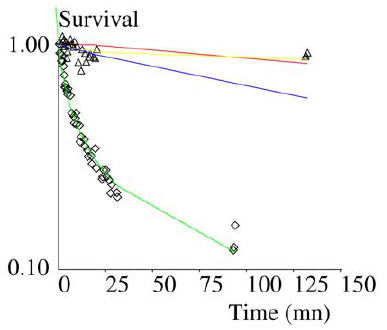
Figure 5. Force free survival of attachments between micro- spheres and ICAM-1-coated surfaces. Anti-ICAM-1-coated Qdots were incubated with surfaces coated with monovalent (diamonds) or divalent (triangles) ICAM-1 and spontaneous detachment was de- termined by counting bound Qdots on a microscope area of 1 m m 2 . Each point represents about 800–1000 particles. Green line: fit of monovalent binding with constants k(0,0) = 0.167 mn 2 1 and a(0)=0.252 mn 2 1 (Eq. 2). Red line: calculated survival curve for dimers, two bonds at time zero, k on =0, MSD=0.0105. Blue line: calculated survival for dimers, one bond at time zero, k on =0, MSD=0.025. Yellow line: calculated survival curve for dimers, one bond at time zero, k on =1.4 mn 2 1 , MSD=0.0052.